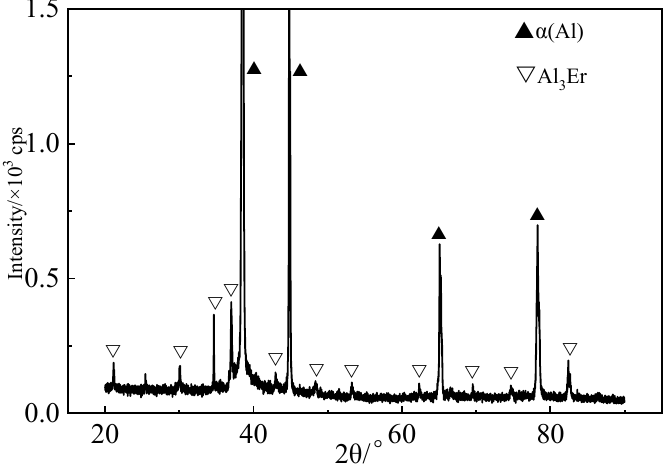
Figure 2. XRD pattern of the as-cast Al-5Zn-0.03In-1Er alloy.